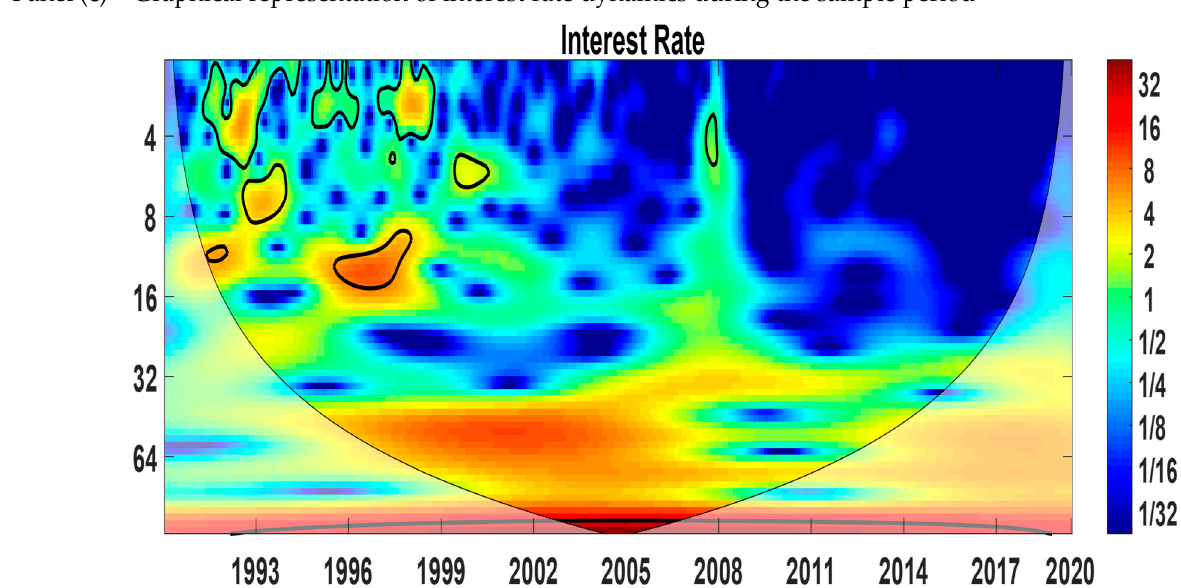
Figure 2. Wavelet power spectrum. Panel ( a ): Growth, ( b ): Inflation, and ( c ): Interest rate. Source: Author’s own contri- bution.